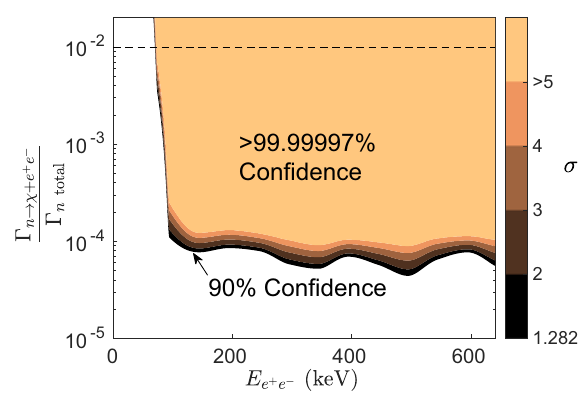
Figure 10. Confidence limits on the branching ratio of the neutron dark decay channel, as a function of the kinetic energy of the produced e + e − pair. This is directly related to the proposed χ mass by m = m − 2 m − E , which has a range of χ n e e + e − 937 . 900 MeV < m χ < 938 . 543 MeV. A branching ratio of 10 − 2 , which would be required to explain the neutron lifetime anomaly if n → χ + e + e − were the only allowed final state, is shown by the dashed